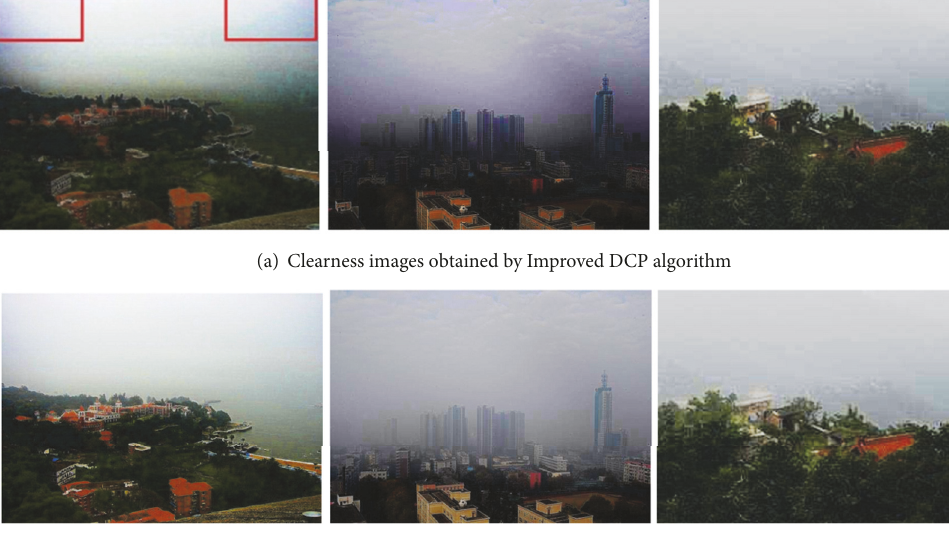
Figure 9: Visual comparison of clearness